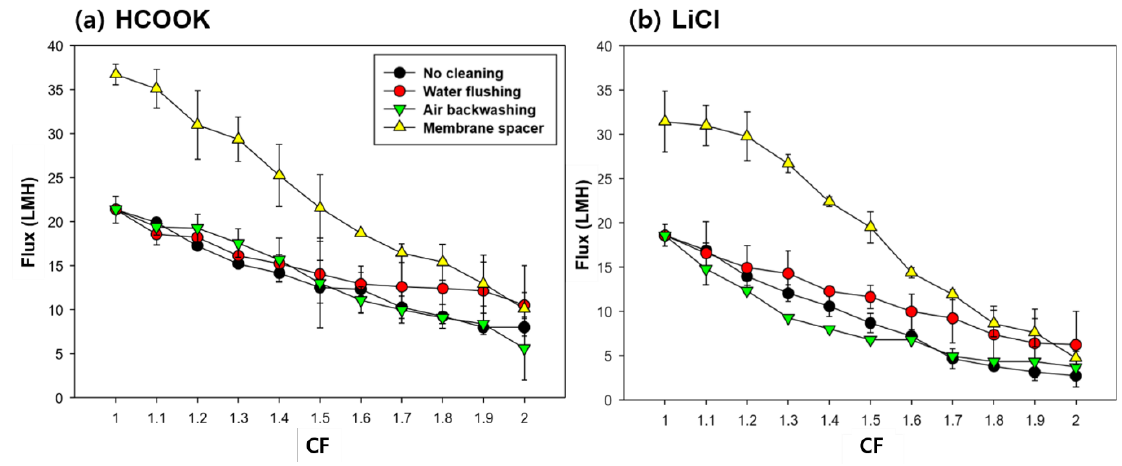
Figure 6. Flux decline patterns as a function of CF when DCMD was operated with different fouling strategies in the concentrating of (a) HCOOK and (b) LiCl (feed volumes of HCOOK and LiCl were 0.65 L and 0.80 L, respectively. The feed temperature was 70 °C. HCOOK and LiCl were concentrated from 35 wt% to 70 wt% and 20 wt% to 40 wt%, respectively).